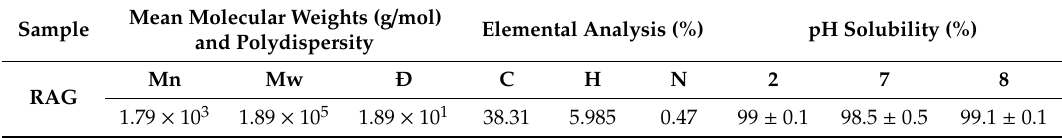
Table 1. Chemical feature results obtained of RAG and its pH